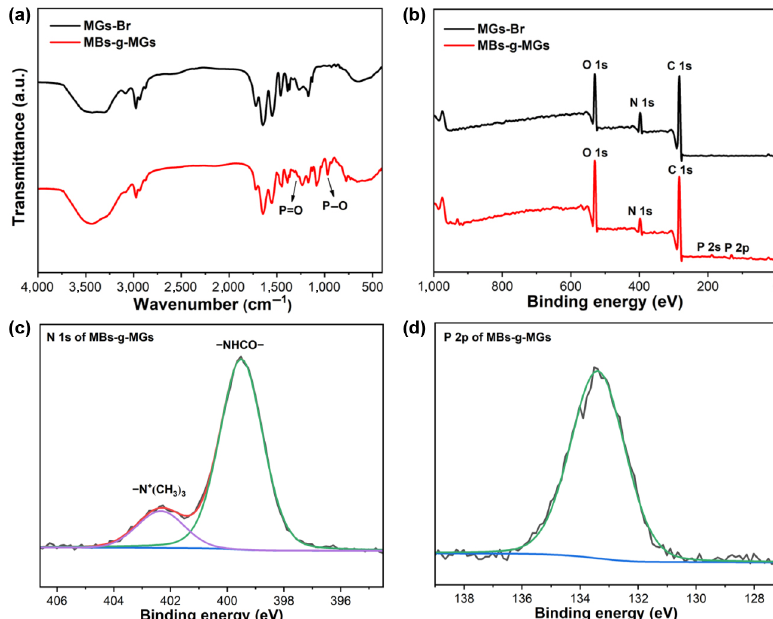
Fig. 2 (a) FTIR spectra of MGs-Br and MBs-g-MGs. (b) XPS spectra of MGs-Br and MBs-g-MGs. (c) XPS deconvolution analysis of N 1s in MBs-g-MGs. (d) XPS deconvolution analysis of P 2p in